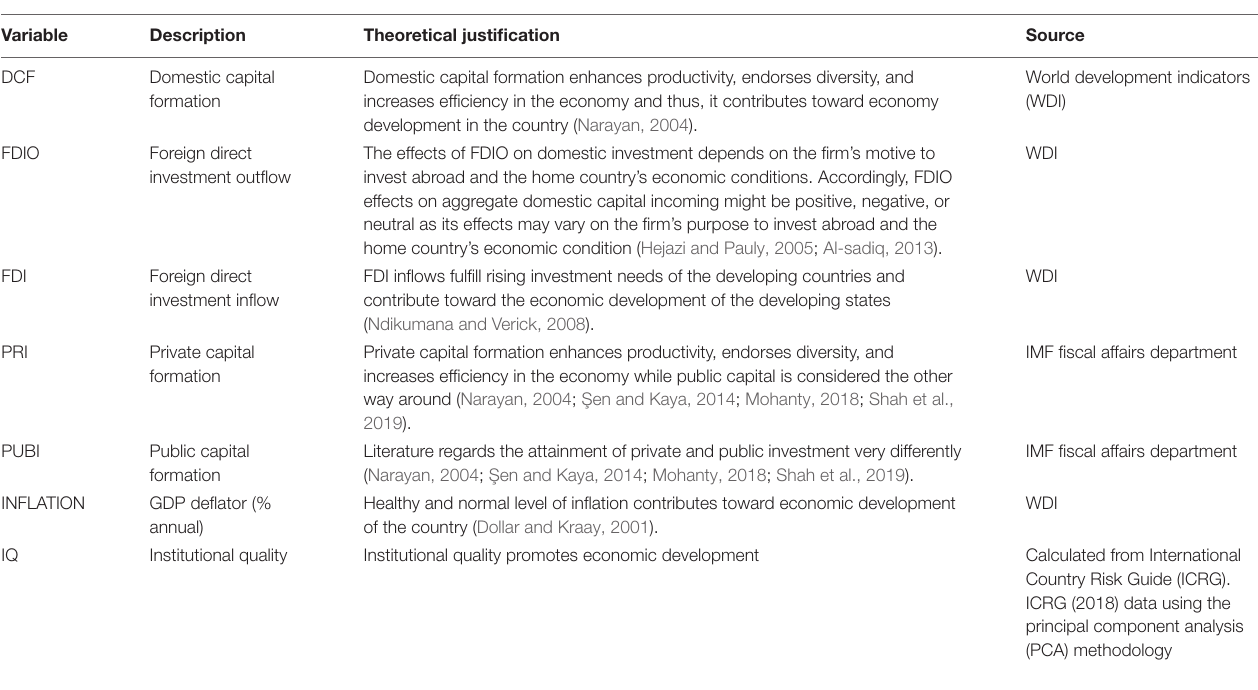
TABLE 3 | Description and source of the